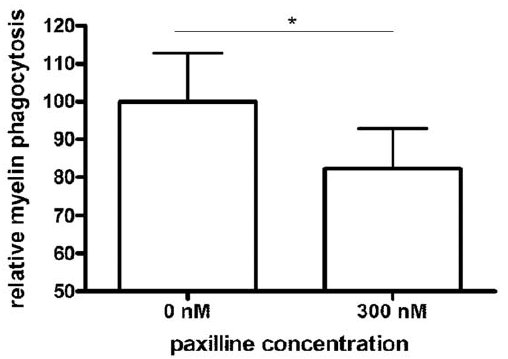
Figure 10. Myelin phagocytosis assay. The influence of paxillin, a specific blocker of the KCNMA1 channel, on myelin phagocytosis was studied to evaluate the possible biological involvement of this protein in EAE and/or MS related disease processes. After macrophage activation, myelin and paxillin were added and phagocytosis was measured by flow